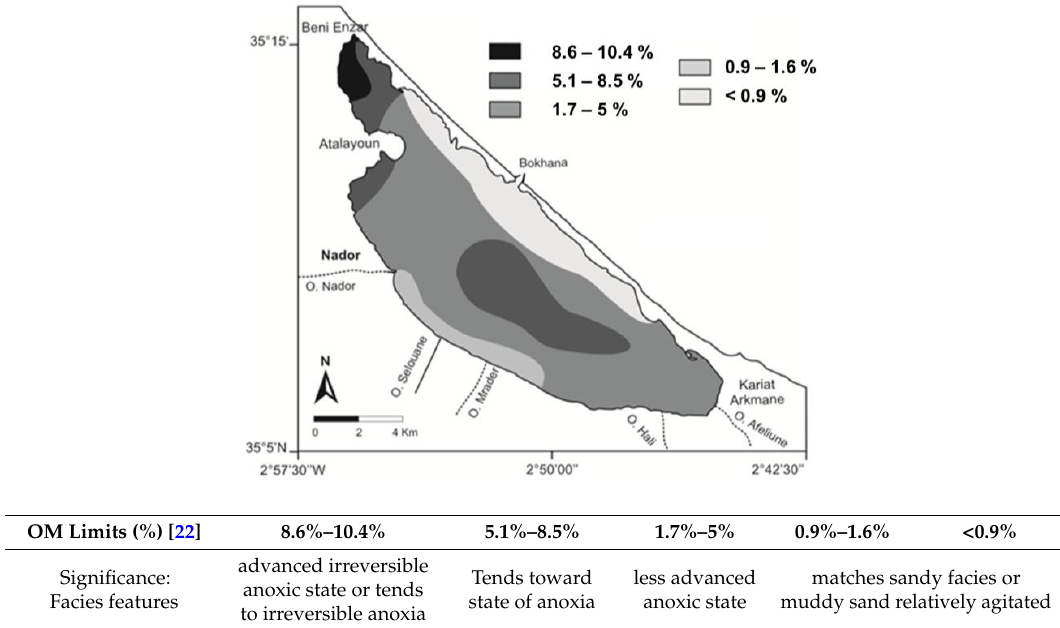
Figure 7. Distribution of organic matter (OM) in surface sediment of the Nador lagoon seabed.